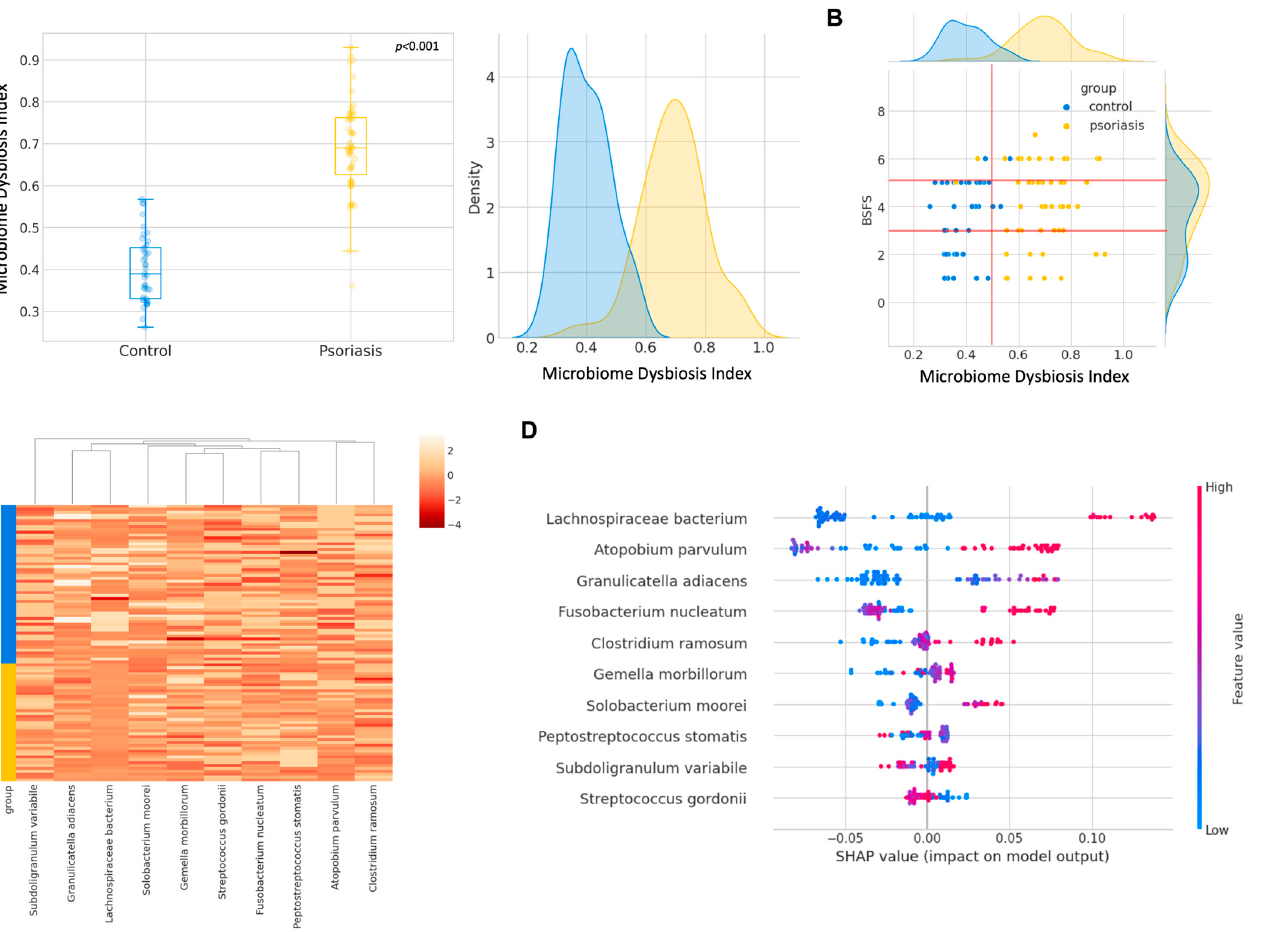
Figure 6. Development of machine learning derived gut microbiome dysbiosis index (MDI) ( A ) Boxplot and kernel density distribution of the gut dysbiosis index. ( B ) Biplot of MDI with Bristol Stool Form Scale (BSFS). ( C ) Heatmap of log 2 ∆ Ct stratified by group. ( D ) Feature importance of each microbial marker on random forest model output.